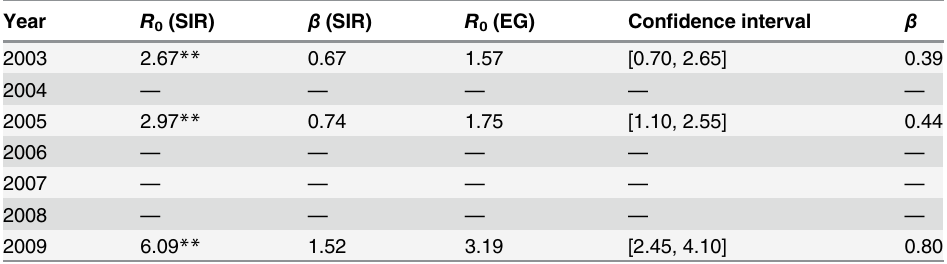
Table 3. Second outbreak of influenza. The t -test statistically significant p < 0.05 is marked with ** .